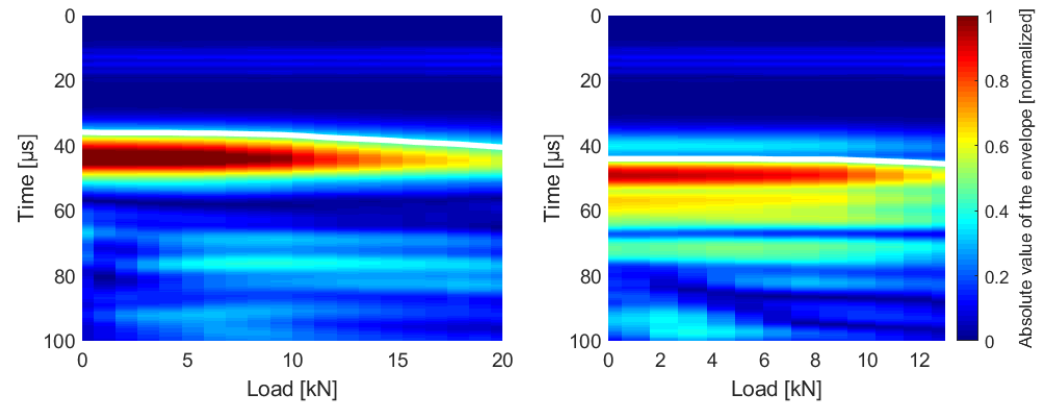
Figure 4. Absolute value of the envelope of measured time signals after each load level for a 0/90 and a +45/ − 45 test specimen. The white line indicates the arrival time of the wave package at the sensor. Left : 0/90 test specimen 1–20. Right : +45/ − 45 test specimen